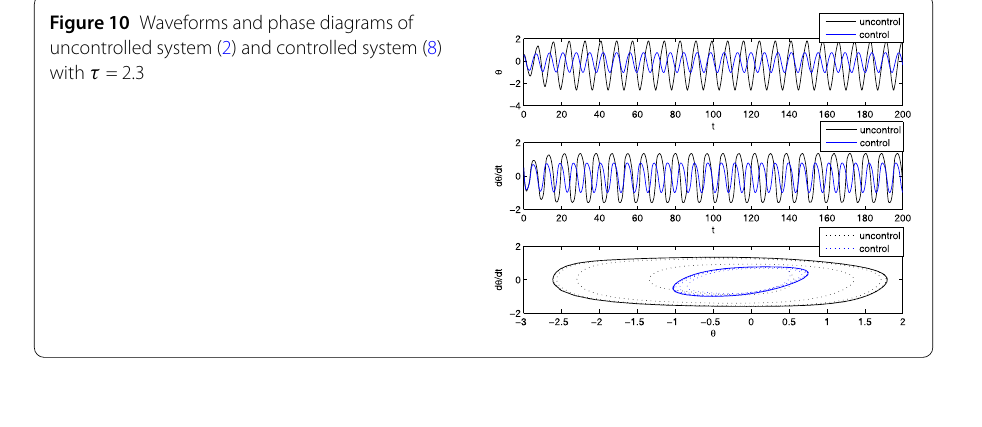
Figure 11 Waveforms and phase diagrams of uncontrolled system (2) and controlled system (8) with τ = 2.7